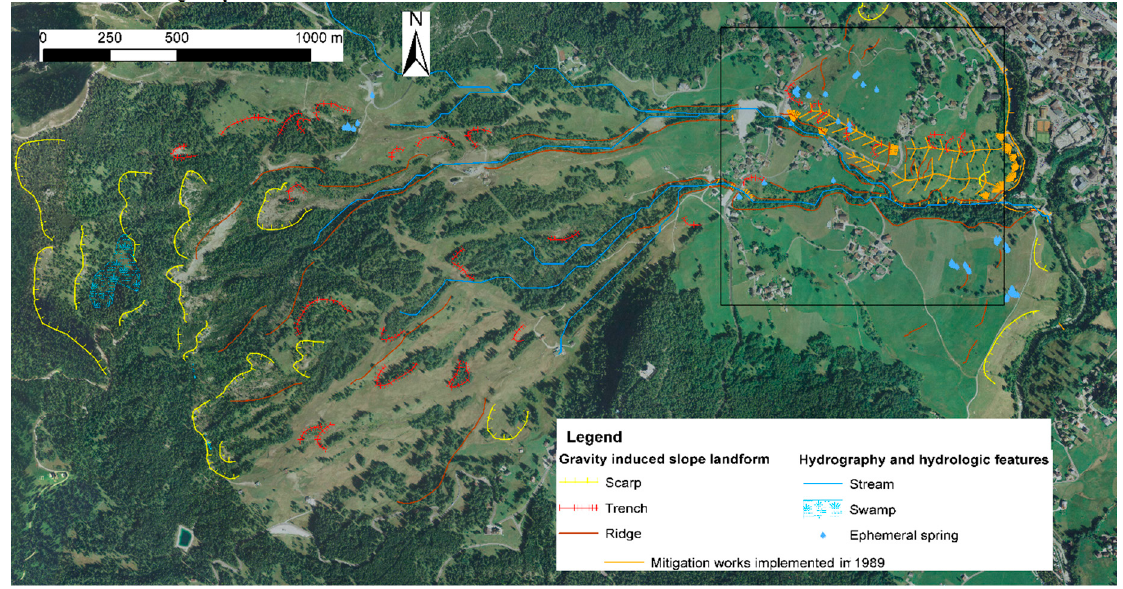
Figure 2. Geomorphological evidence in the Mortisa slope and location of the mitigation measures implemented in 1989. In black is the frame of Figure 3.